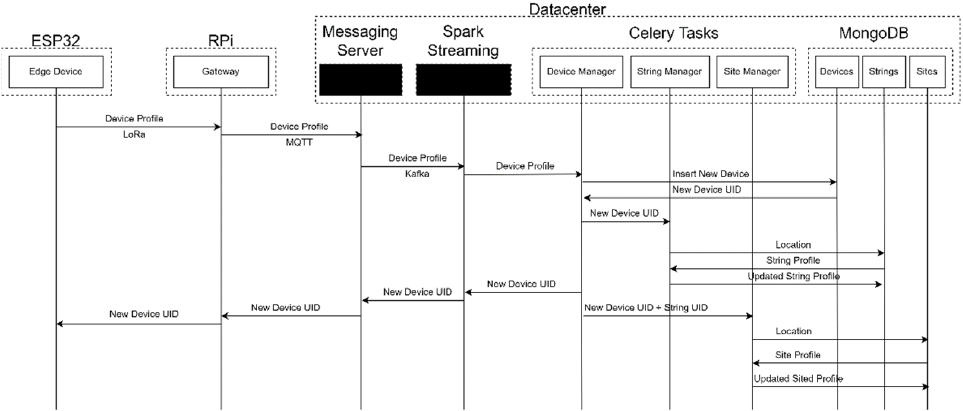
Figure 13. Sequence diagram for the fourth step of adding a new device.